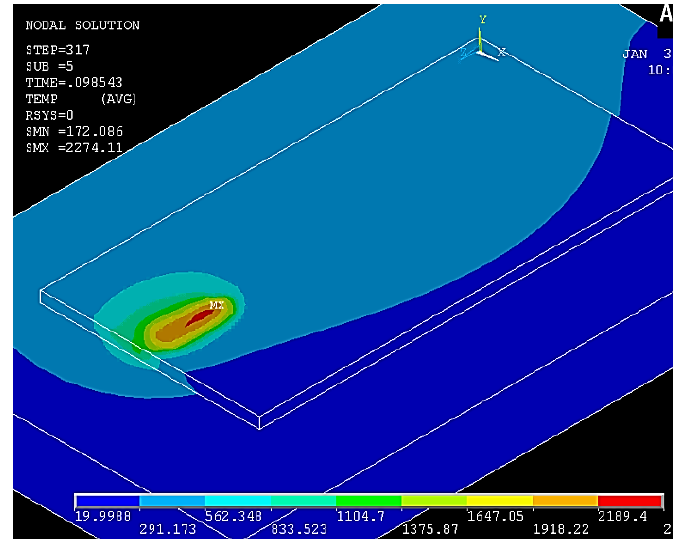
Figure 5. Temperature cloud diagram of the finite element simulation process.